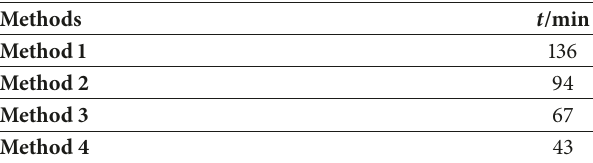
Table 7: Analysis times of four different